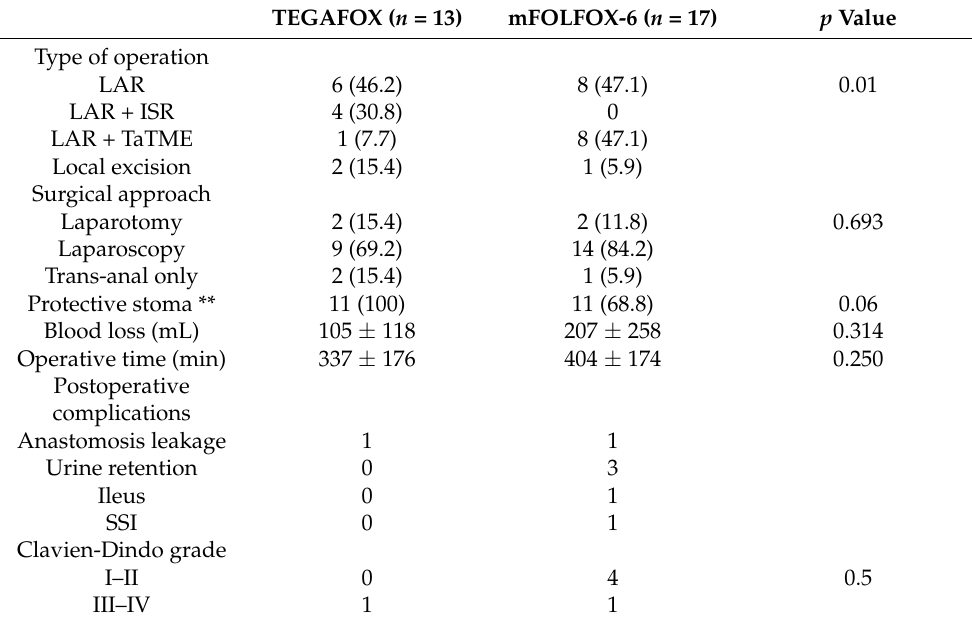
Table 4. Operative characteristics and postoperative complications by chemotherapy group.